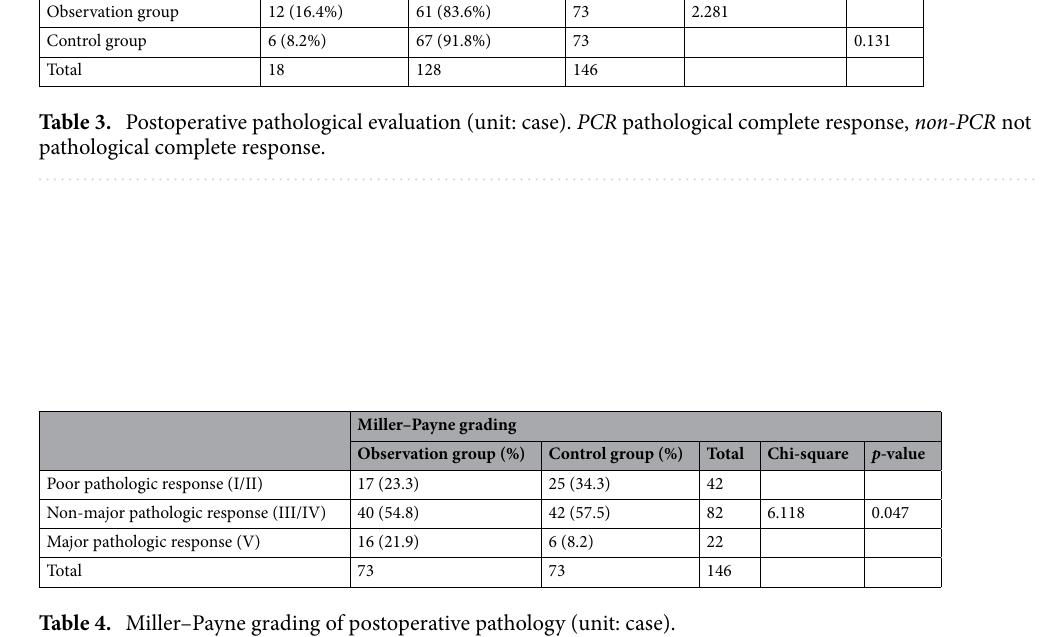
Table 4. Miller–Payne grading of postoperative pathology (unit: